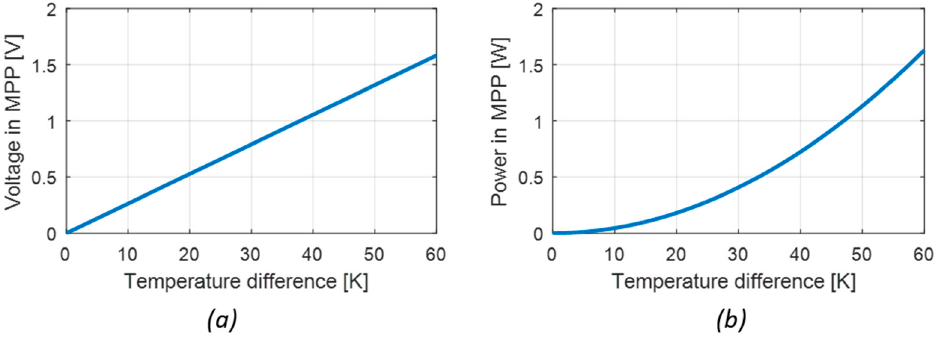
Figure 7. ( a ) V MPP– Δ T curve ( b ) P MPP– Δ T curve.